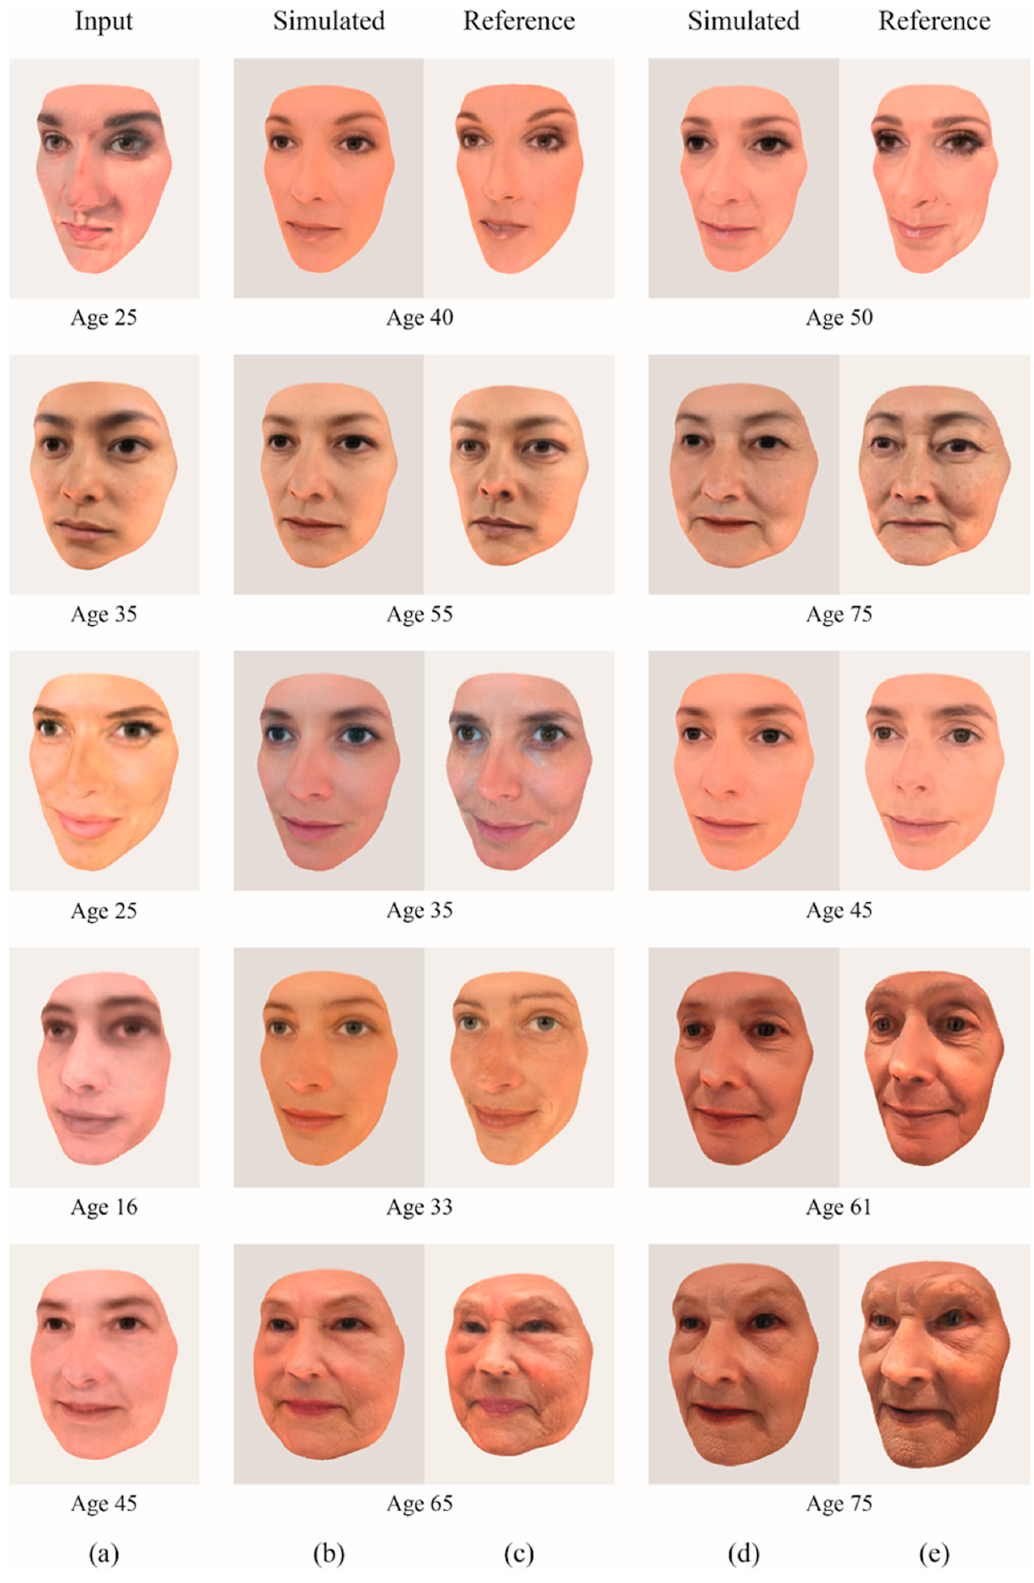
Figure 5. Female rendering results of applying the proposed 3D morphable face aging model (3D F-FAM). ( a ) Input textured mesh at actual age; ( b , d ) output at target age—older; and ( c , e ) reference textured mesh at the same age as the output to apply in the evaluation mode.